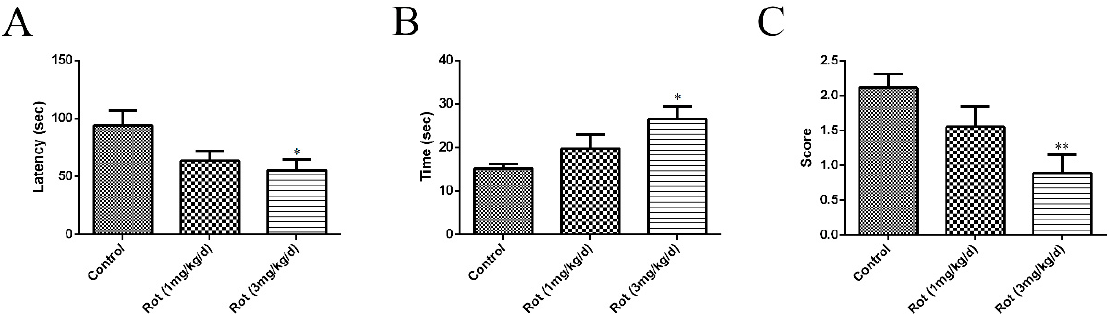
Figure 1. Rotenone caused dose-dependent changes in behavioral tests in mice: 1 mg / kg / d or 3 mg / kg / d of rotenone (dissolved in normal saline with 2% DMSO) was applied to ICR mice through intraperitoneal injection for 21 consecutive days to establish a Parkinson’s disease (PD) model. Normal saline with 2% DMSO was used in the control group. ( A ) The time of latency in falling was recorded after the last injection of rotenone. ( B ) The total time for each mouse to orient downward and descend to the floor was recorded. ( C ) The score of the traction test was assessed in each group. Data are represented as the mean ± SEM ( n = 10); * p < 0.05 and ** p < 0.01 versus control group.